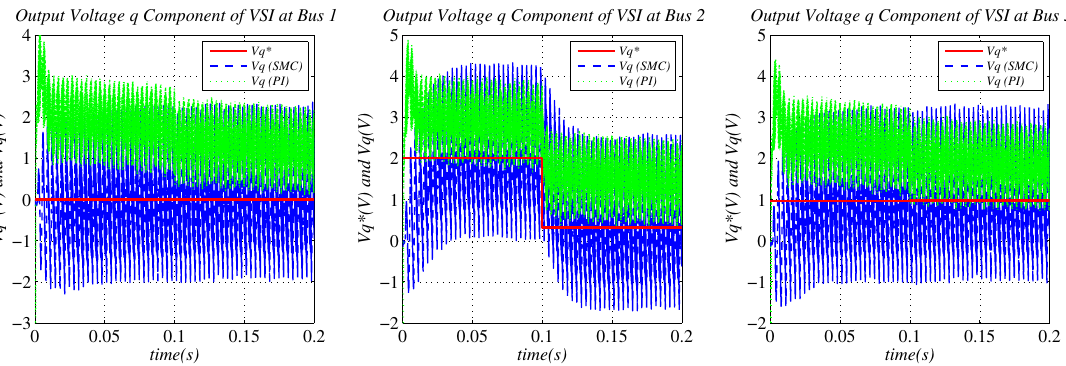
Figure 11. Output voltage q components of the VSI at Buses 1, 2, and 3 (comparison of the SMC and PI controls).